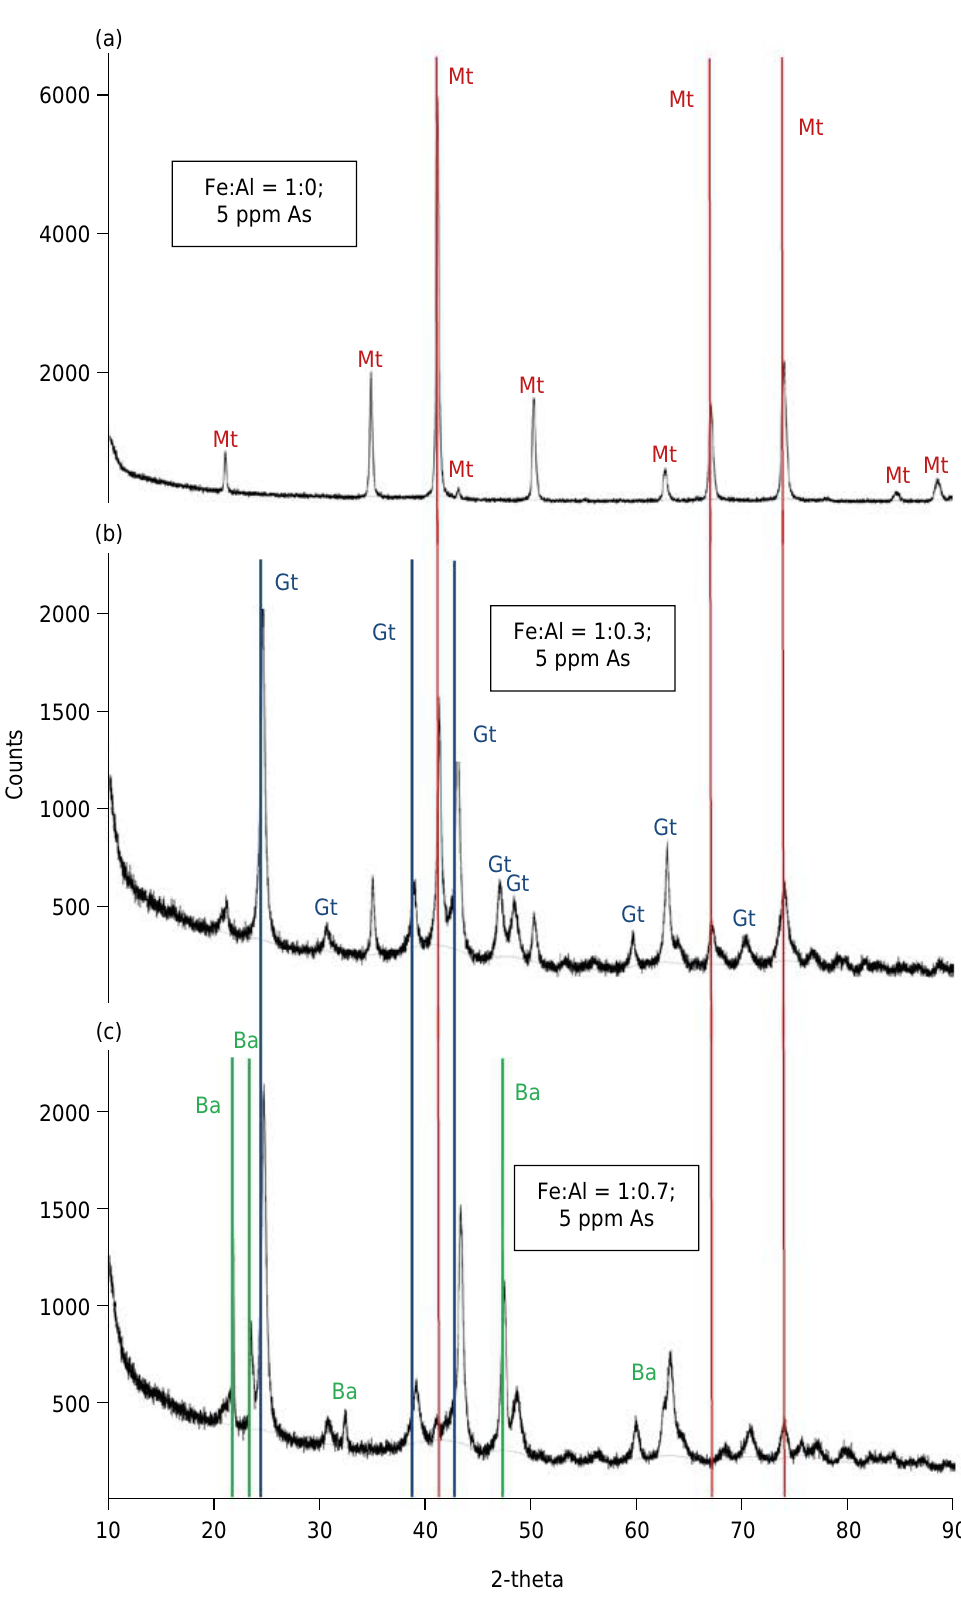
Figure 2. X-ray diffractograms of samples synthesized from sulfate salts with (a) Fe:Al = 1:0 and 5 ppm As (magnetite only); (b) Fe:Al = 1:0.3 and 5 ppm As (goethite and magnetite); and (c) Fe:Al = 1:0.7 and 5 ppm As (goethite and bayerite with traces of magnetite). Mt = magnetite; Gt = goethite; Ba = bayerite. The three strongest lines for each mineral have been marked with a continuous line. Note the slight shift in the goethite spectra relative to “pure” goethite, which is attributed to the presence of Al in the goethite